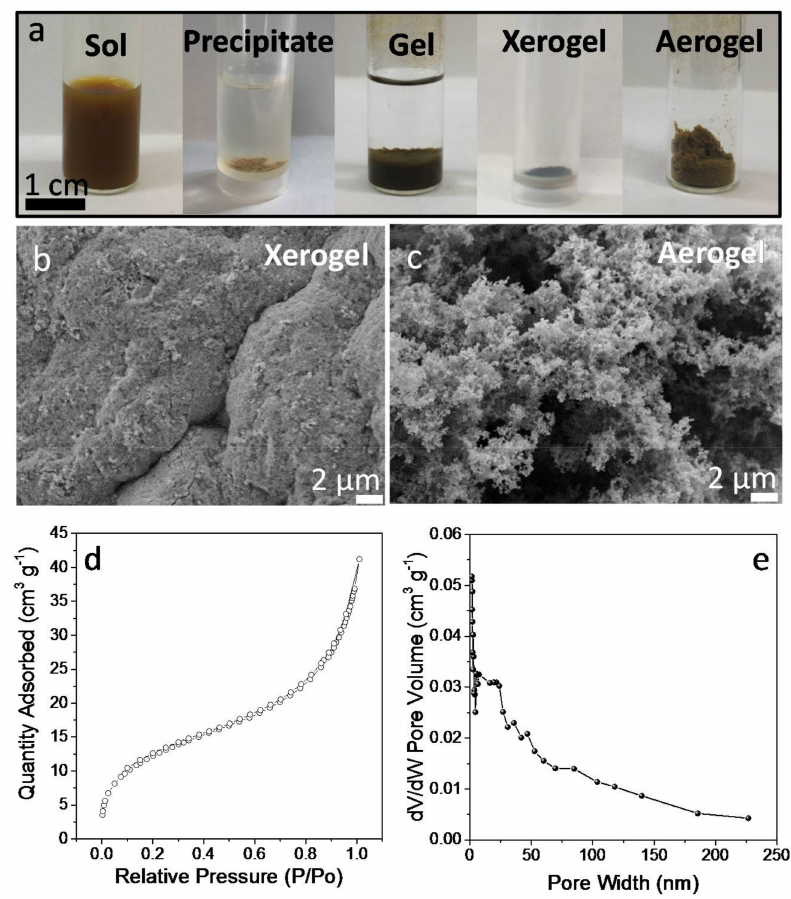
Figure 5. ( a ) optical images of the CGS NC-based sol, precipitate, gel, aerogel and xerogel; ( b ) SEM micrograph of a CGS xerogel; ( c ) SEM micrograph of a CGS aerogel; ( d ) adsorption/desorption isotherm cycle from a CGS NC-aerogel, and ( e ) its corresponding BJH pore size